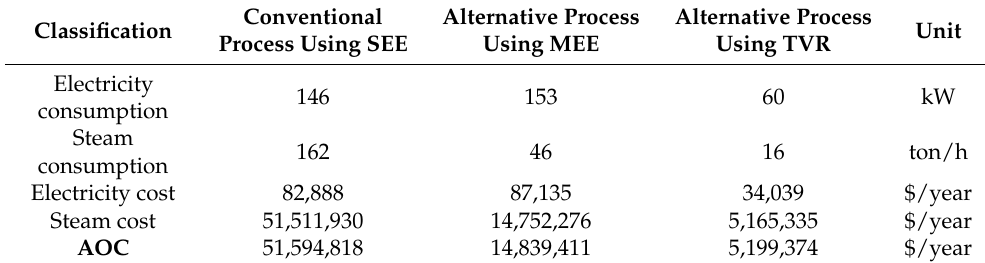
Table 8. AOC of each process.